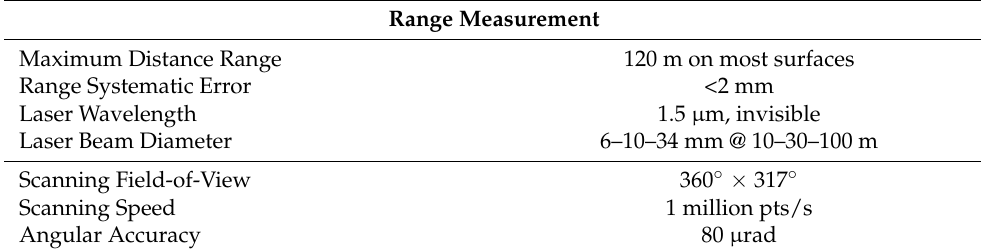
Table 1. Trimble TX8 terrestrial laser scanning device specifications.